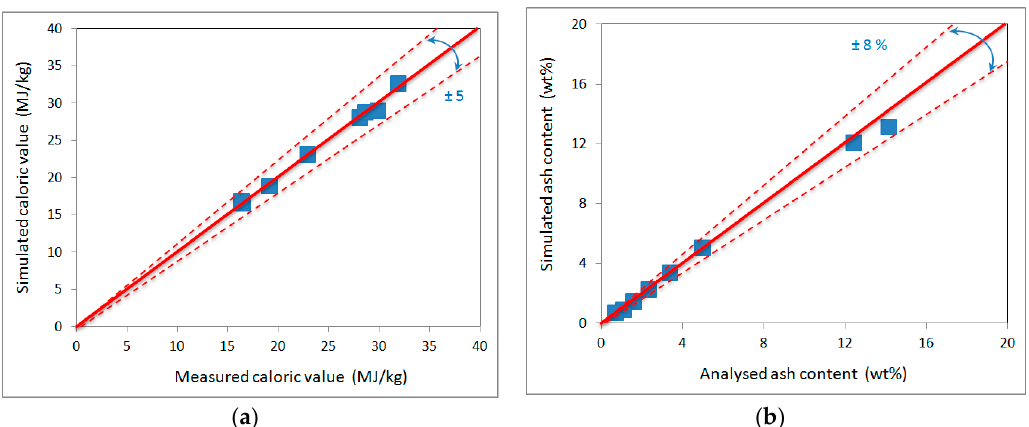
Figure 7. Comparison between the measured and simulated results of determining the caloric value ( a ) and ash content in carbonaceous fuel combustion experiments ( b ).